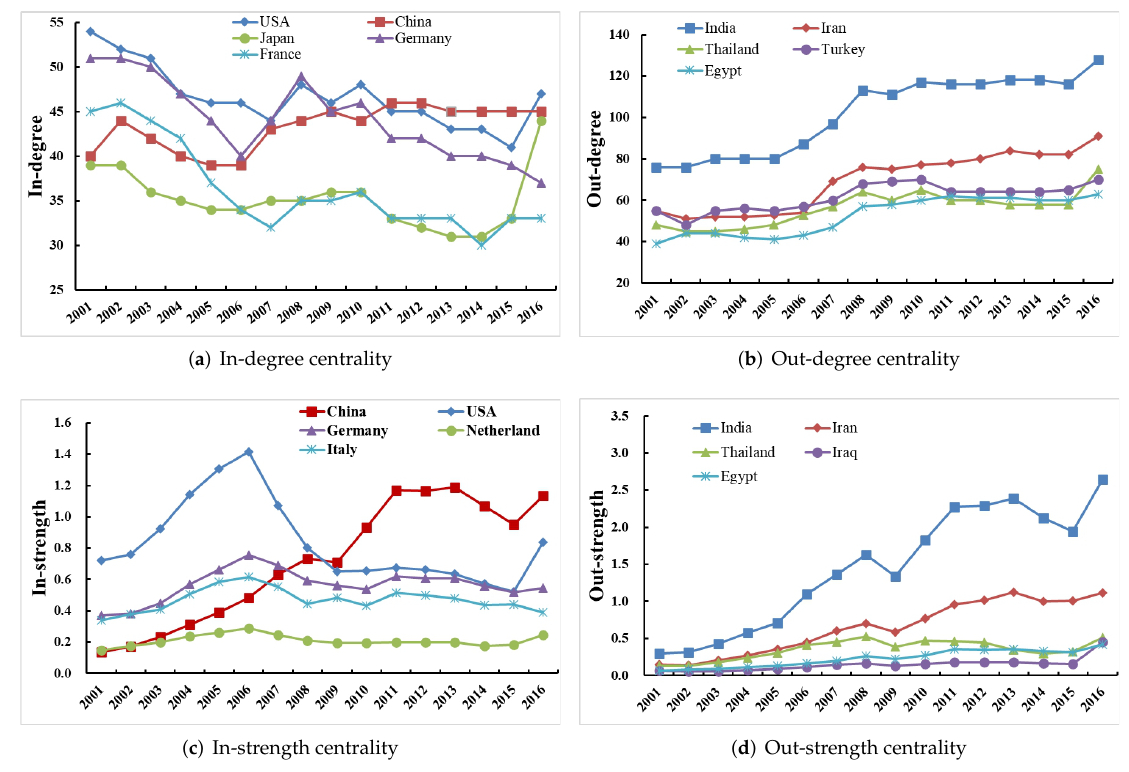
Figure 3. Top 5 economies ranked by degree and strength centrality, 2016. Unit of strength centrality: 10 8